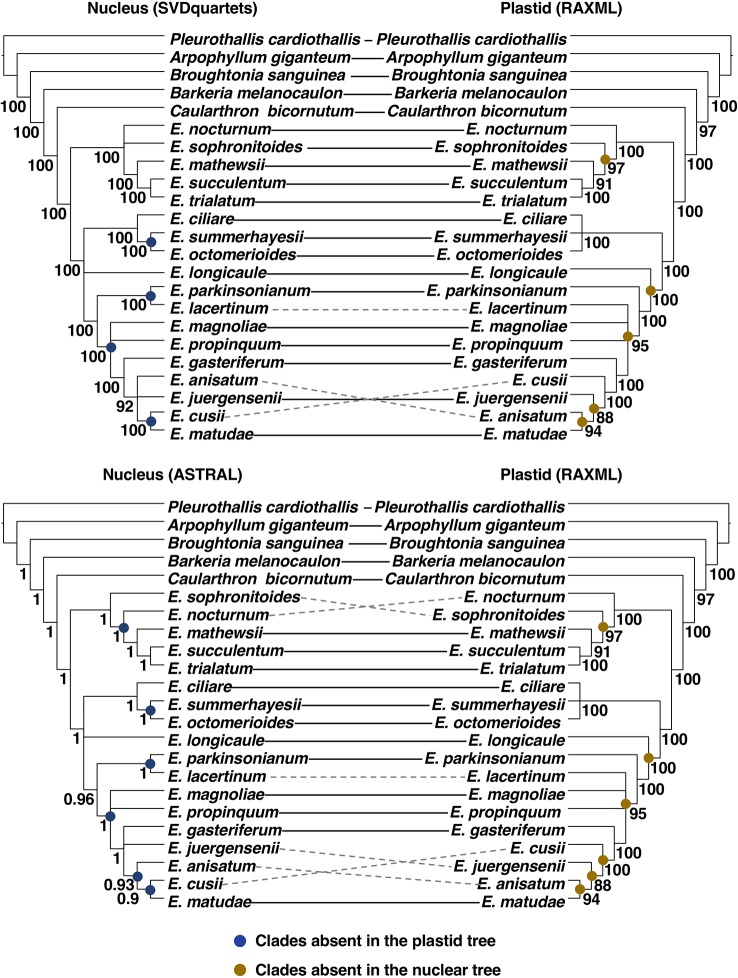
Comparison between topologies obtained from the analyses of the nuclear and plastid data sets. Continuous lines connecting names of terminal indicate congruence between topologies, whereas dotted lines indicate strongly supported (BS > 85 or LPP > 0.85) incongruencies. Blue full circles at the internal nodes of the nuclear trees indicate clades absent in the plastid tree and yellow full circles at the internal nodes of the plastid tree indicate clades absent in the nuclear trees. For ease of visualization trees were converted to cladogram and nodes with BS < 85 or LPP< 0.85 were collapsed.